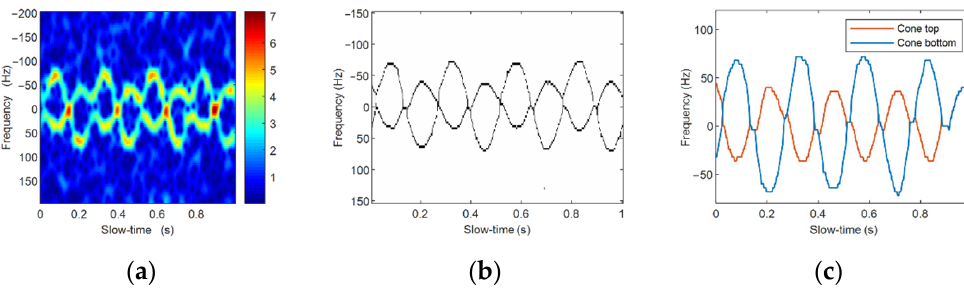
Figure 16. The echo micro-Doppler curves and skeletons when SNR is − 10 dB. ( a ) Echo micro-Dop- pler curves. ( b ) Skeletons of echo micro-Doppler curves.